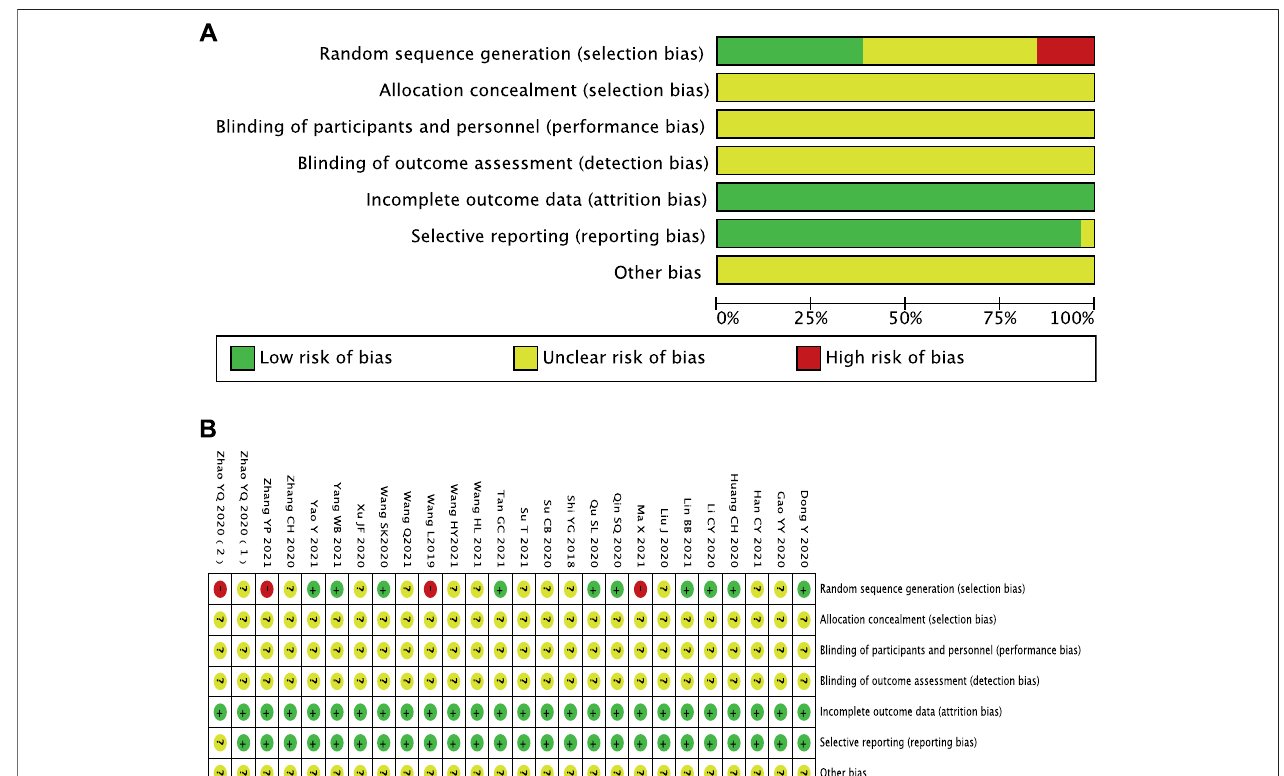
FIGURE 2 | Assessment of risk of bias. (A) Risk of bias graph and (B) risk of bias summary.